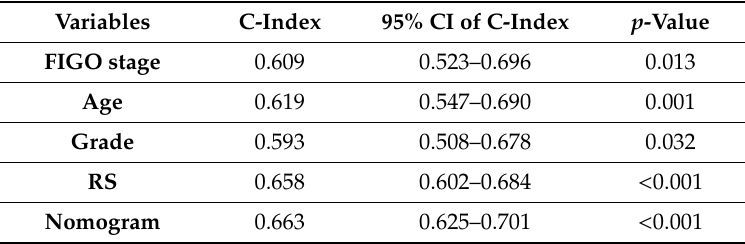
Table 3. Comparison of concordance indexes (C-indexes) between clinical features, risk score (RS) and